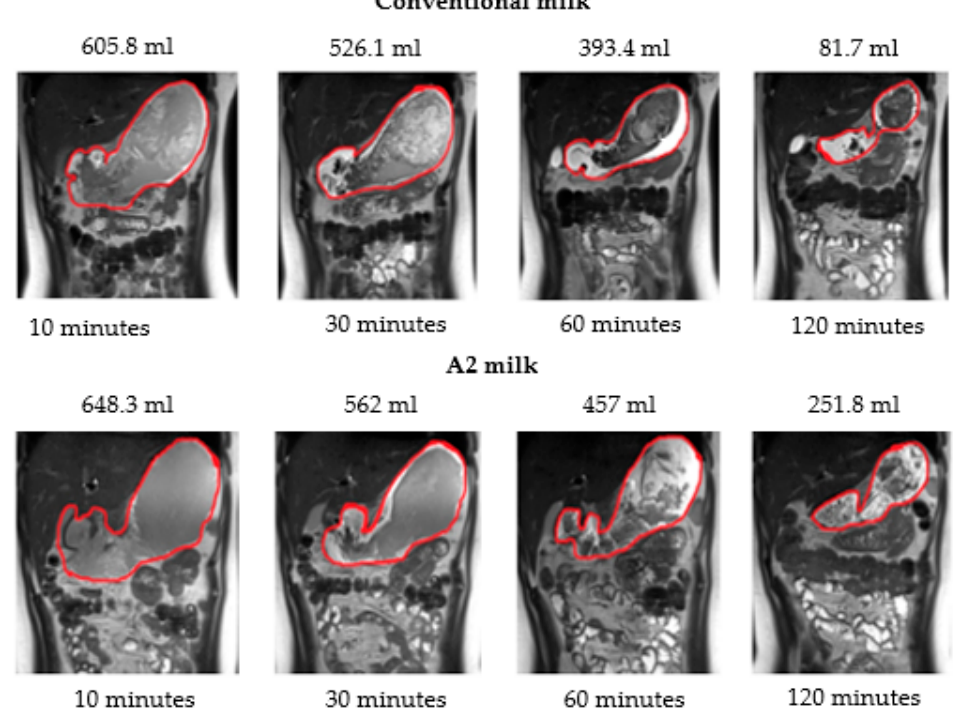
Figure 5. Magnetic resonance images showing the gastric volume of conventional milk and A2 milk and volume calculated in milliliters (mL) at 10, 30, 60 and 120 min.